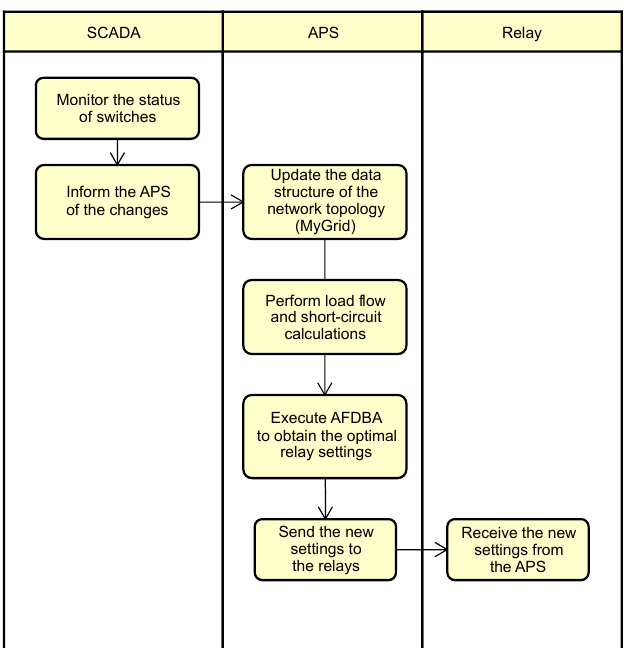
Figure 2. Flowchart of the proposed APS.